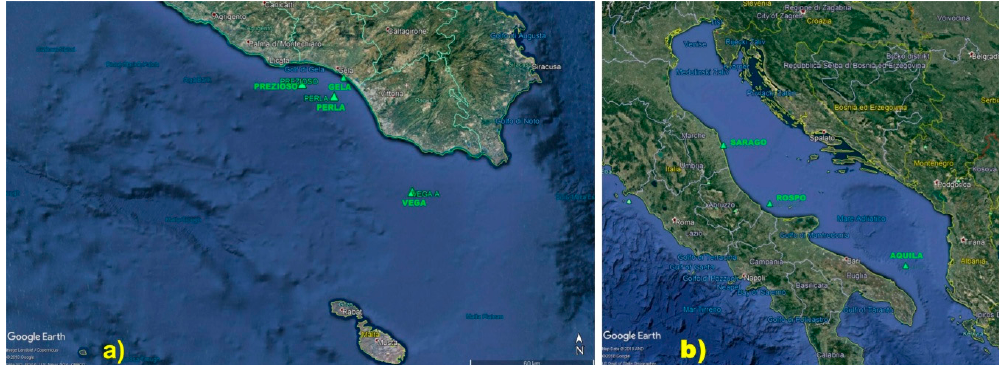
Figure 1. Spatial distribution of the four active oil platforms (green triangles) in the Sicily Channel ( a ), and the three in the medium–low Adriatic Sea ( b ). and the three in the medium–low Adriatic Sea ( b